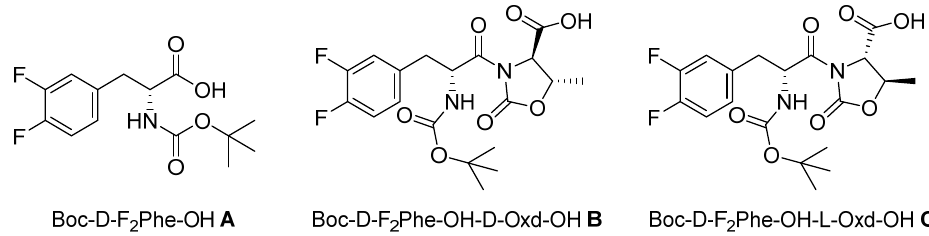
Figure 1. Chemical structure of gelators A , B, and C .